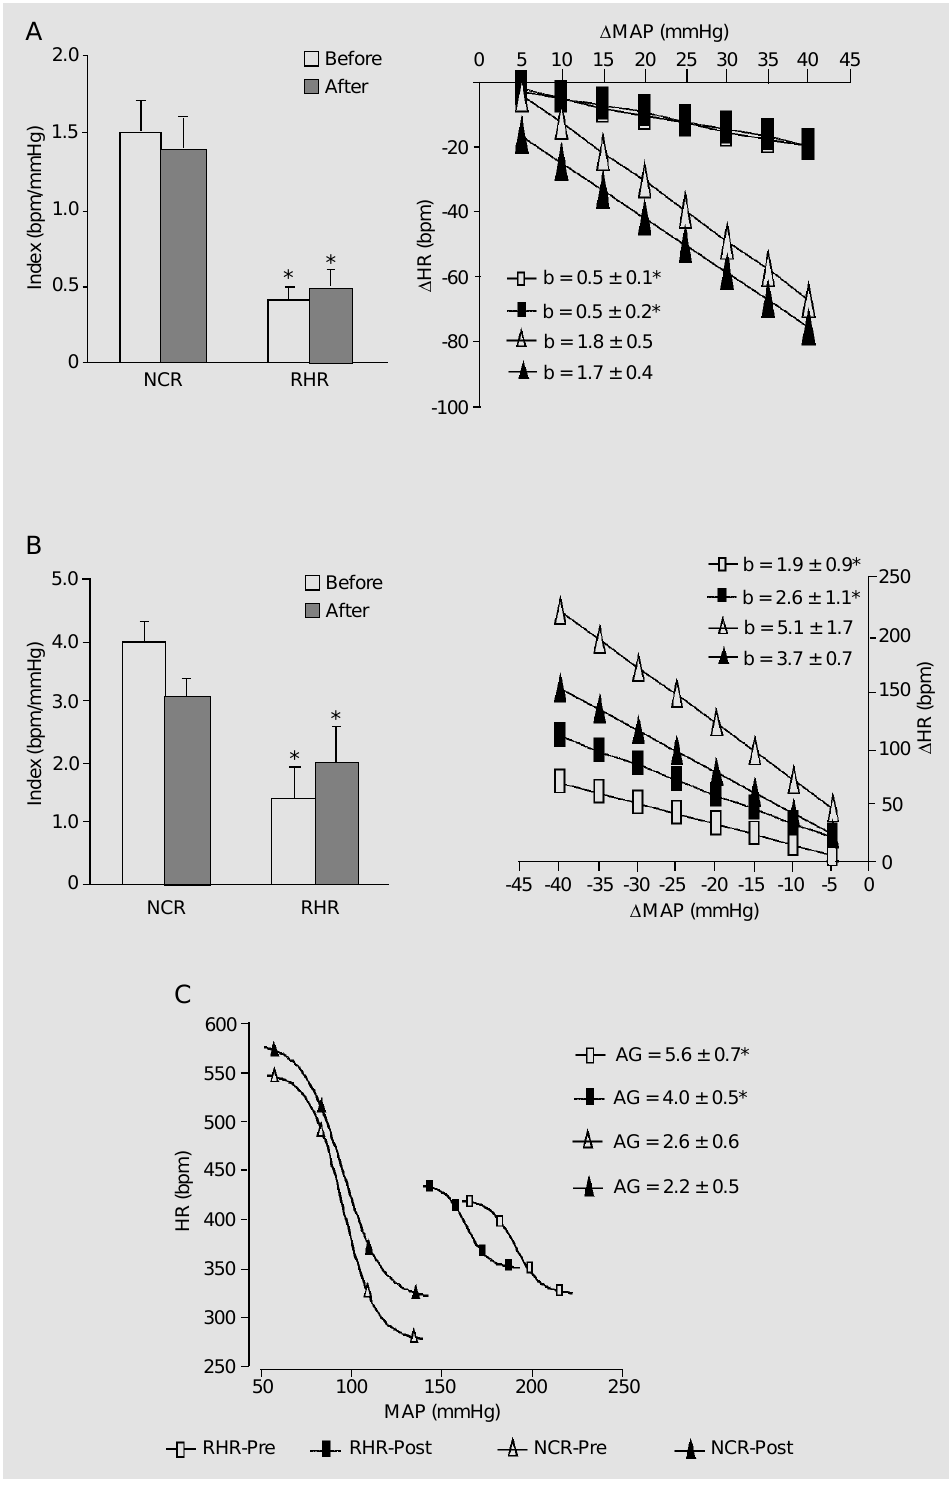
Figure 2 - Baroreflex sensitivity of conscious normotensive con- trol rats (NCR) or chronic 1K1C renal hypertensive rats (RHR), determined by mean index and linear regression for bradycardic (A) and tachycardic (B) re- sponses, and by logistic function (C) before (Pre) and after (Post) acute administration of losartan (10 mg/kg, iv ). *P<0.05 com- pared to normotensive rats (Stu- dent t -test). AG, Average